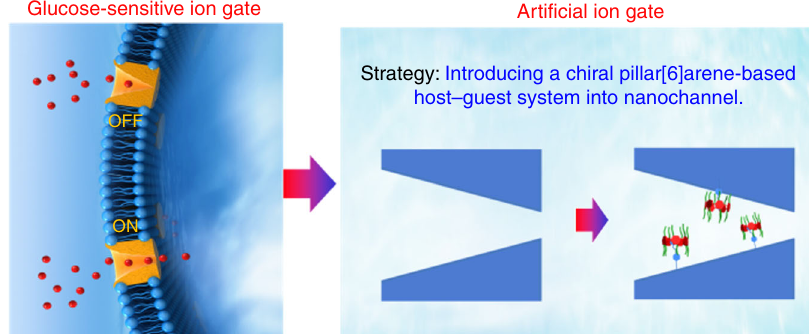
Fig. 1 Schematic of the design of a biomimetic glucose-enantiomer-driven ion gate using host – guest